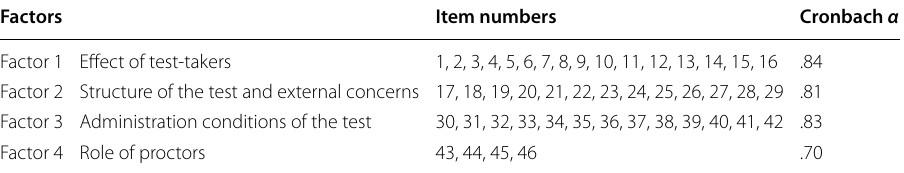
Table 6 The factors of the sources of unreliability of a test scale, the corresponding items, and the Cronbach alpha reliabilities Factors Item numbers